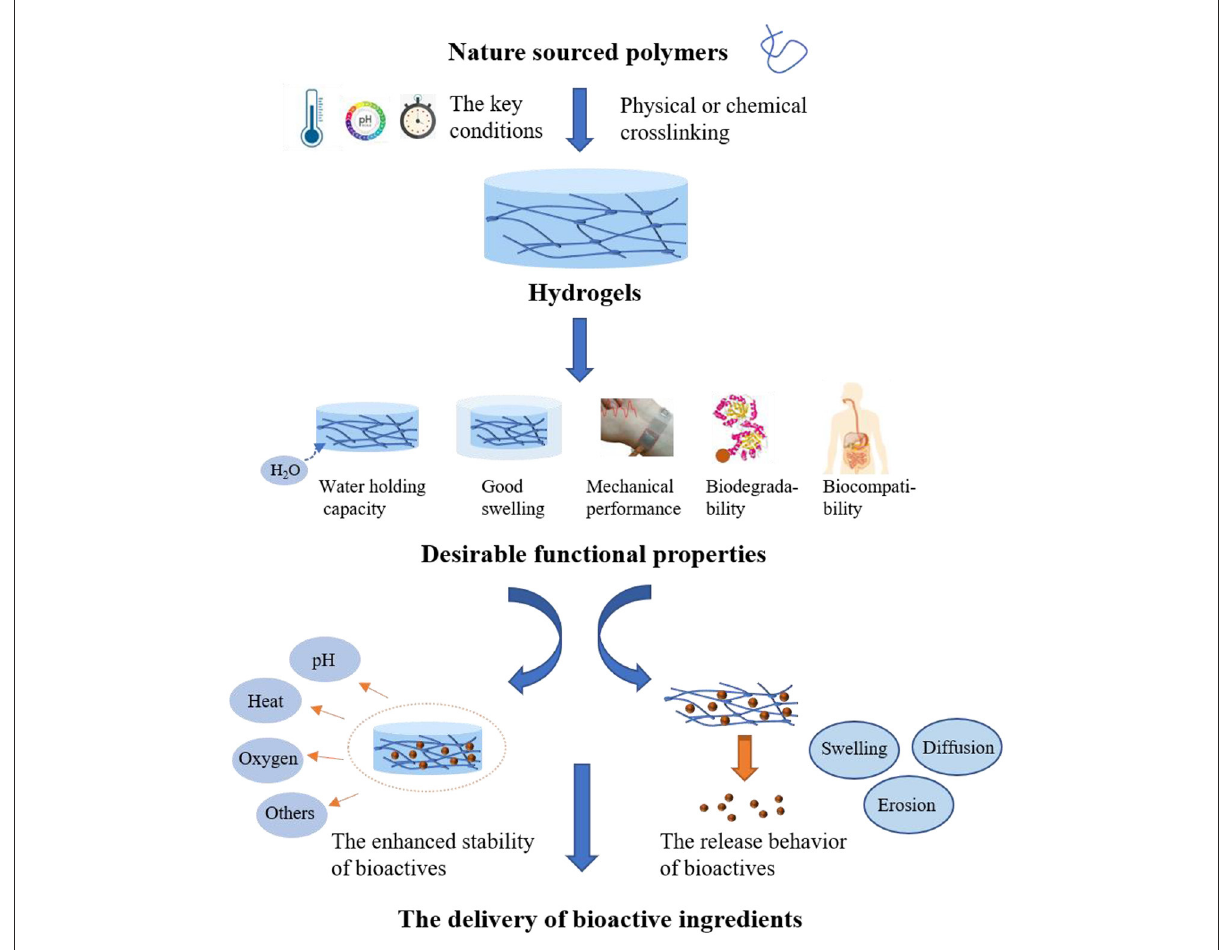
FIGURE4 The factors associated with hydrogels as carriers of bioactive ingredients to realize the effective